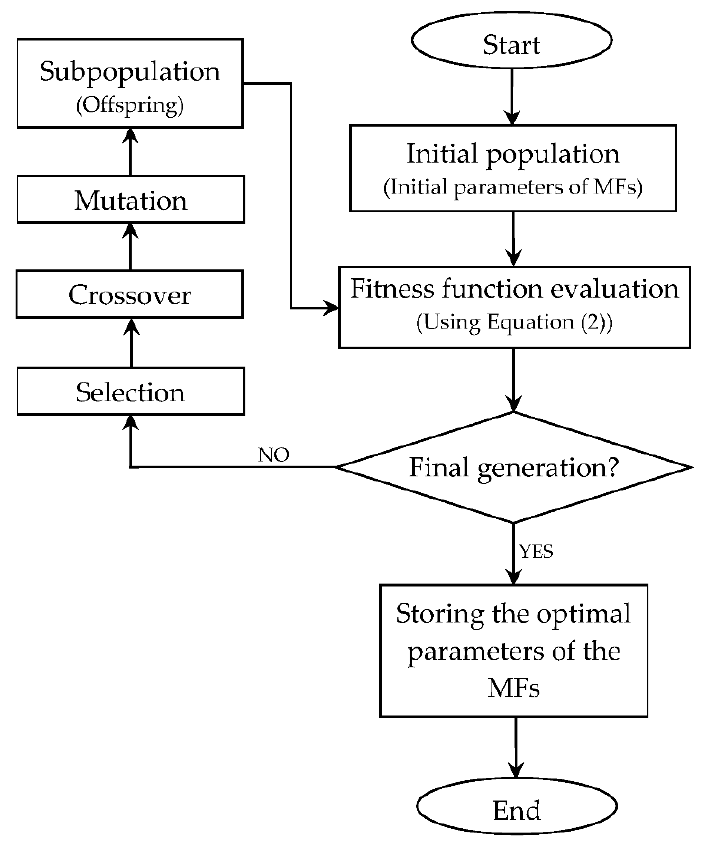
Figure 11. The flow chart of the used genetic algorithm.